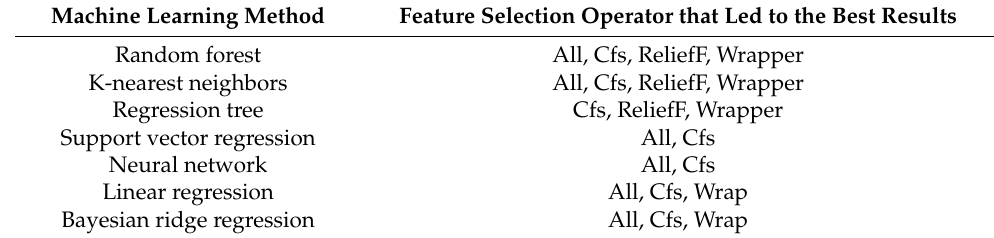
Table 10. Best feature selection operators for each machine learning method. There is no signif- icant difference between the results in the same cell. ‘All’ refers to all features being used, ‘Cfs’ refers to the set of features found by CfsSubsetEval, ‘ReliefF’ refers to the set of features found by ReliefFAttributeEval, and ’Wrapper’ refers to the set of features found by ‘WrapperSubsetEval’.